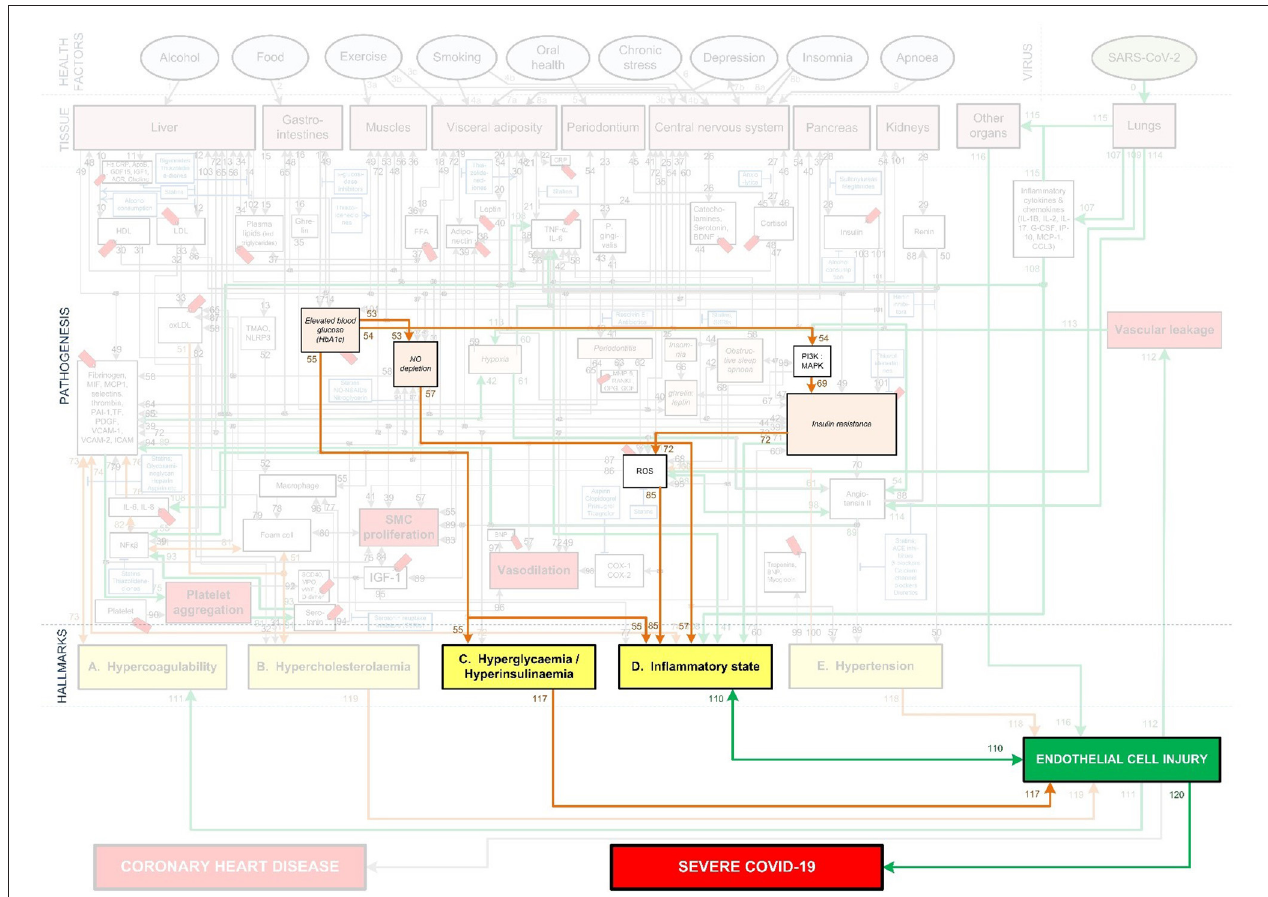
FIGURE 9 | CHD related aggravation of severe Covid-19 in patients with high blood glucose levels.